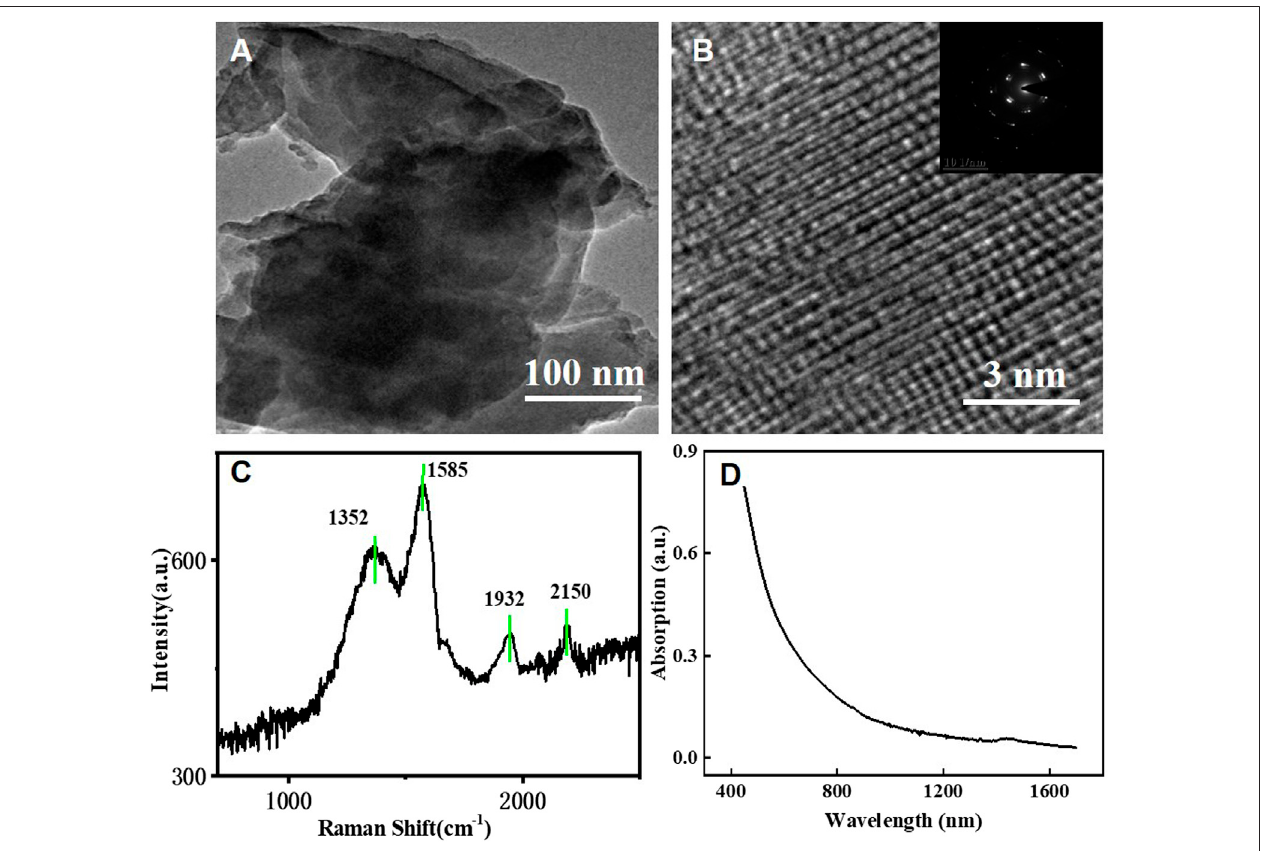
FIGURE 1 | Characterizations of GDY. (A) Transmission electron microcopy (TEM) images of GDY nanosheets, (B) atomic lattice structure of GDY via high- resolution transmission electron microscopy (HRTEM) nanosheets, (C) Raman spectrum, and (D) linear absorption spectrum of GDY dispersions.